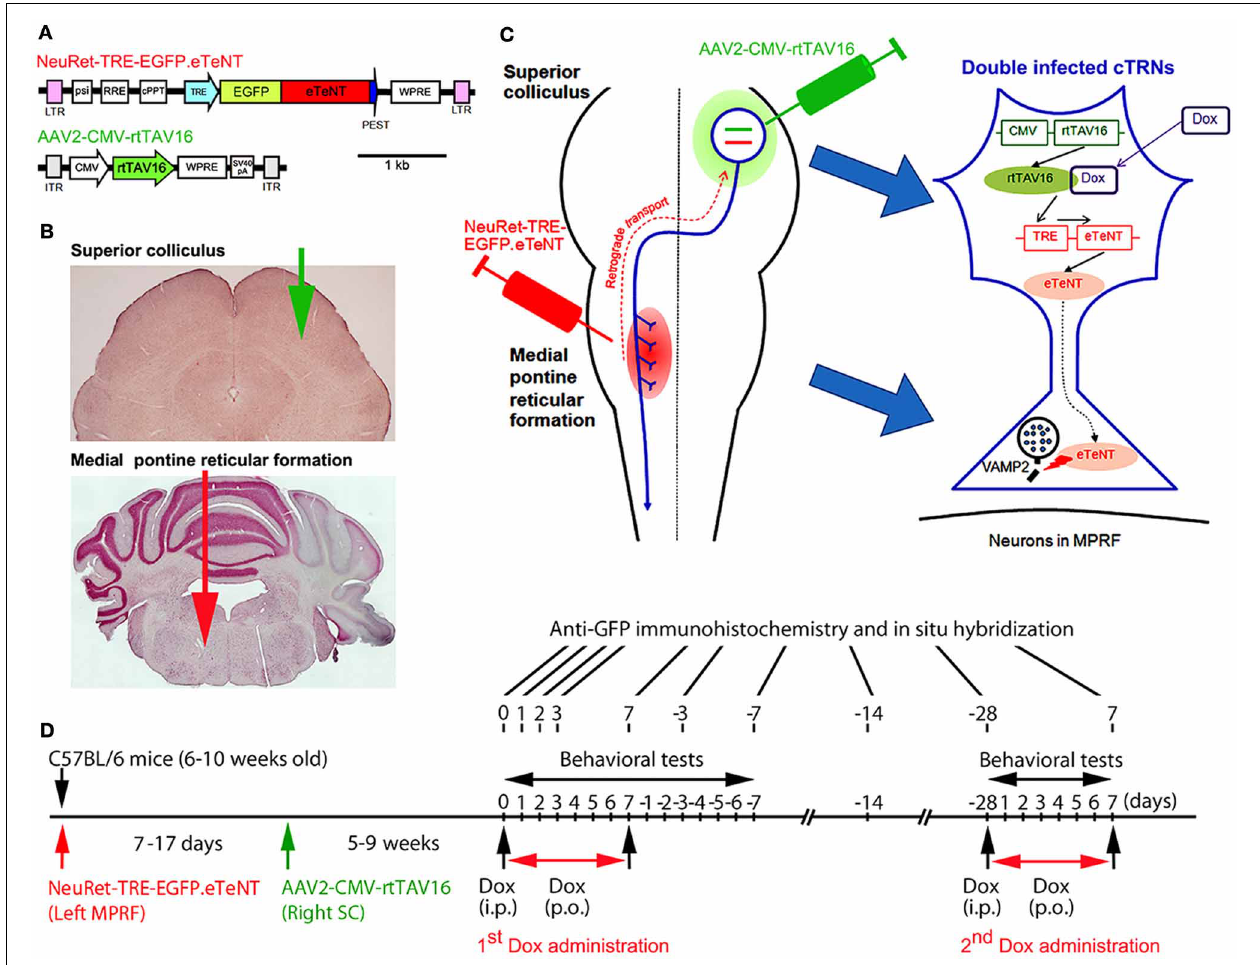
FIGURE 1 | Experimental protocols for the selective blockade of the crossed tectoreticular pathway by double infection with the NeuRet lentiviral vector (carrying EGFP.eTeNT) and the AAV2 vector (carrying the Tet-ON sequence, CMV-rtTAV16). (A) The design of the two viral vectors. (B) Photomicrographs of the superior colliculus (SC) and medial pontine